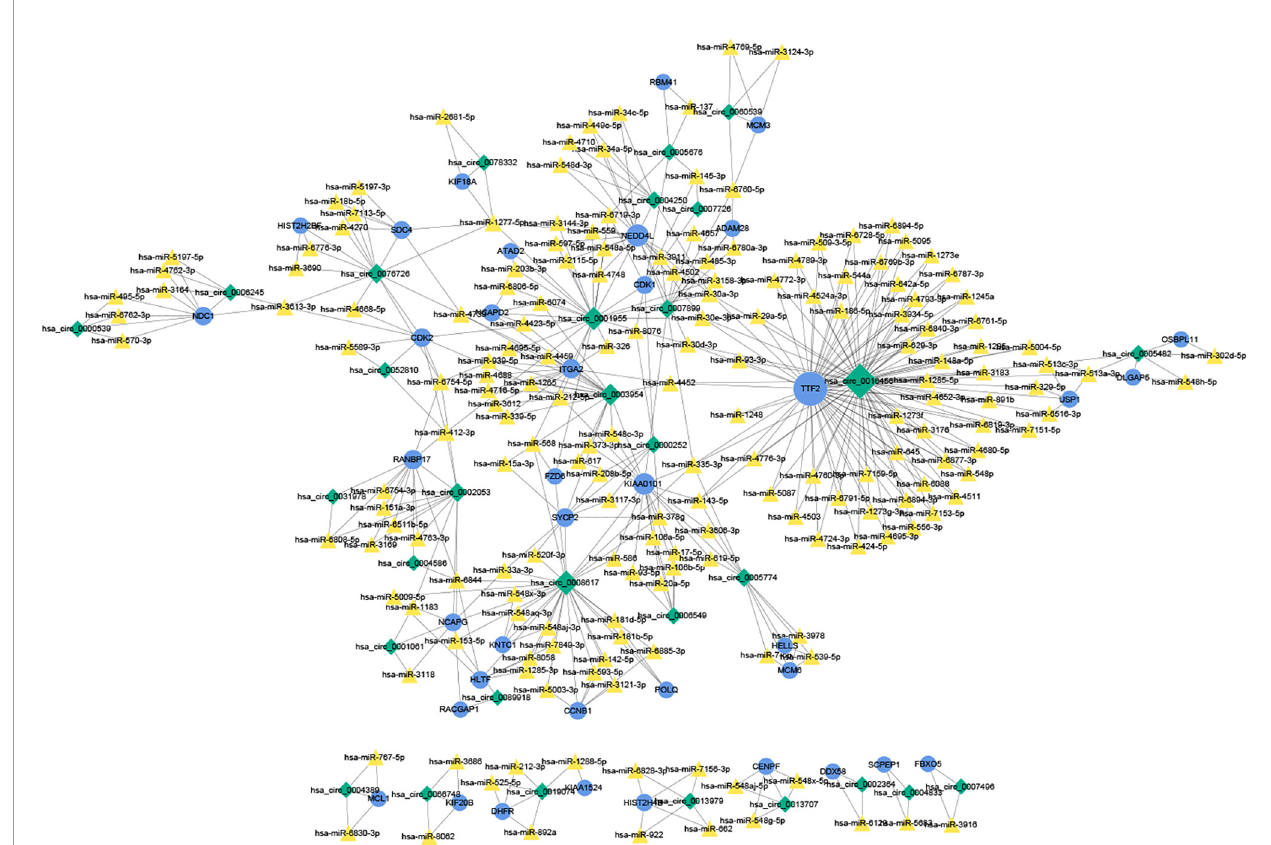
FIGURE 7 | The ceRNA network of circRNAs, miRNAs and mRNAs. The ceRNA relationship pairs were obtained, including 31 circRNAs, 184 miRNAs, and 38 mRNAs. The blue circles represent protein-coding mRNAs, the yellow triangles represent miRNAs and green rhombuses represent circRNAs. The gray solid lines represent the circRNA-miRNA regulatory relationships. The size of the node represents its degree in the network, and the larger the node is, the higher the degree. ceRNA, competing endogenous RNA.